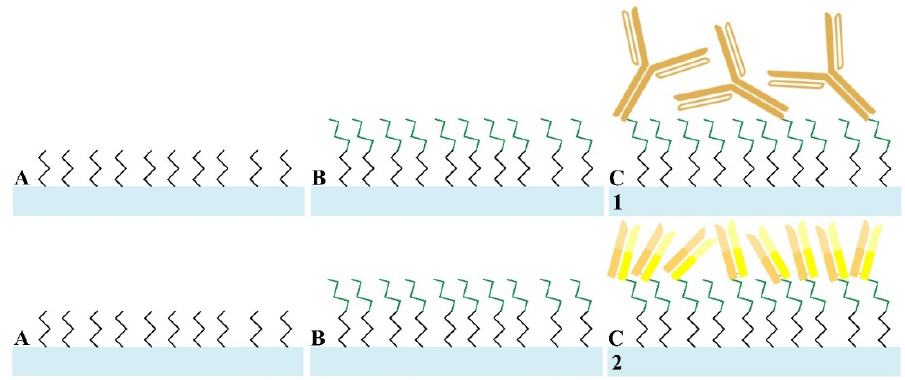
Figure 1. Depiction of the fabrication of Wab/APTES-SiNWFET (sample 1) and Fab/APTES-SiNWFET (sample 2) immunosensors in this study. ( A ) The SiNW channels (light blue bar) were modified with APTES (black short zigzag shapes) and ( B ) GA (green zigzag shapes) before ( C ) immobilizing either the Wab (bronze Y shapes in sample 1) or the Fab (yellow-bronze bars in sample 2).